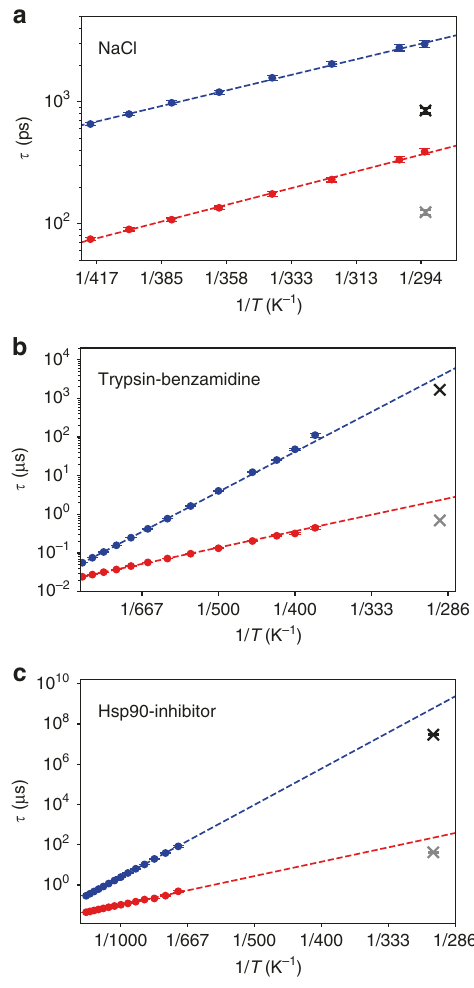
Fig. 2 Prediction of binding and unbinding times. Mean binding (red) and unbinding (blue) times, drawn as a function of the inverse temperature, obtained from T -boosted Langevin simulations of a solvated NaCl, b the trypsin-benzamidine complex, and c the Hsp90-inhibitor complex. Dashed lines represent fi ts ( R 2 = 0.90 − 0.99) to Eq. (4), crosses (binding in grey, unbinding in black) indicate reference results from a unbiased MD simulation 22 and b , c experiment 39,48 .